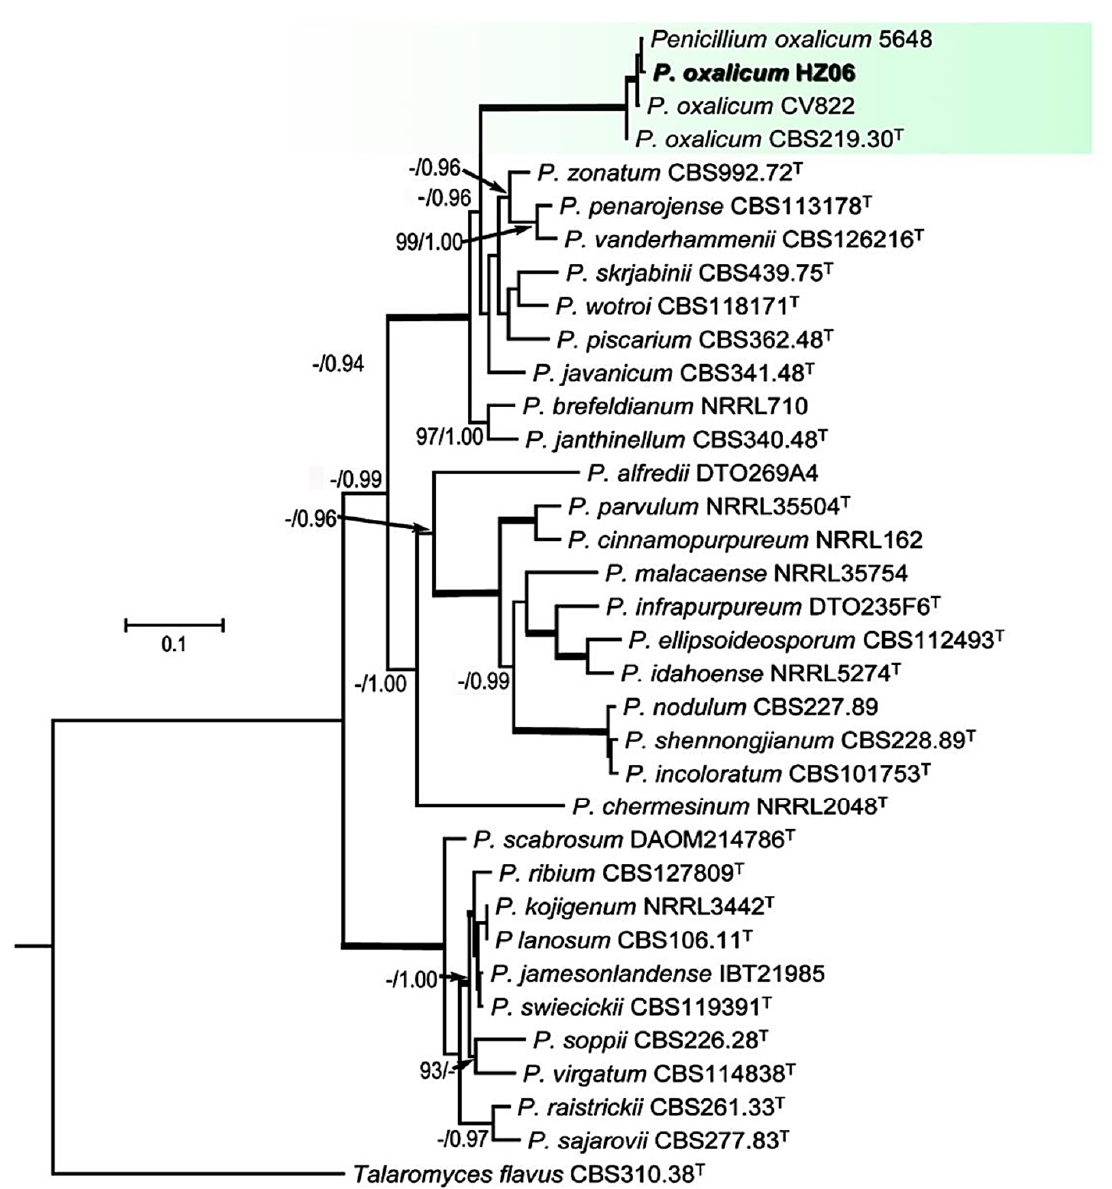
Figure 7. Maximum likelihood (ML) tree generated from the combined ITS region and TUB, RPB2, and CaM sequences of 36 taxa of Penicillium . The tree is rooted with Talaromyces flavus CBS310.38 T . Clades with 100% ML bootstrap branch support and 1.00 Bayesian posterior probabilities (BPP) are indicated by thick black lines. Clades with >80% ML-BS (left) and 0.95 BPP (right) are indicated by the corresponding support values. Dashes indicate support values lower than 80% ML-BS and 0.95 BPP. Species isolated from soil are shown in bold. T: type